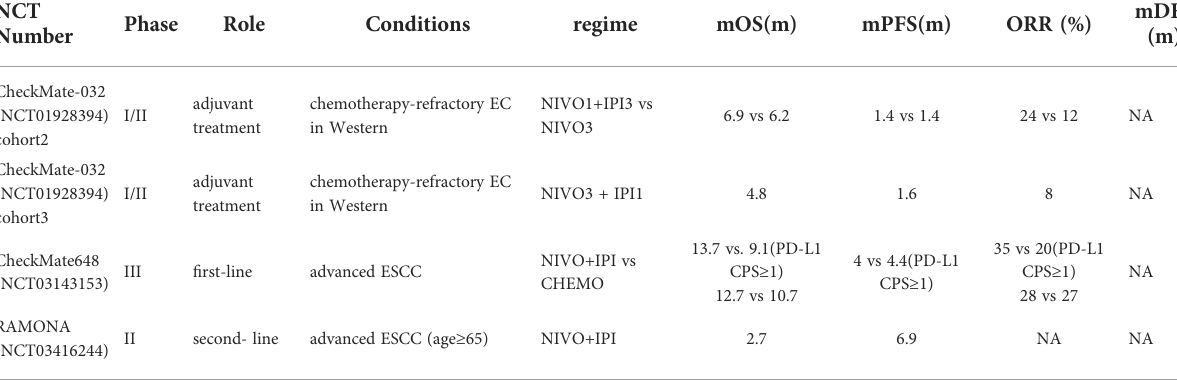
TABLE 2 Clinical Trial of Combination between